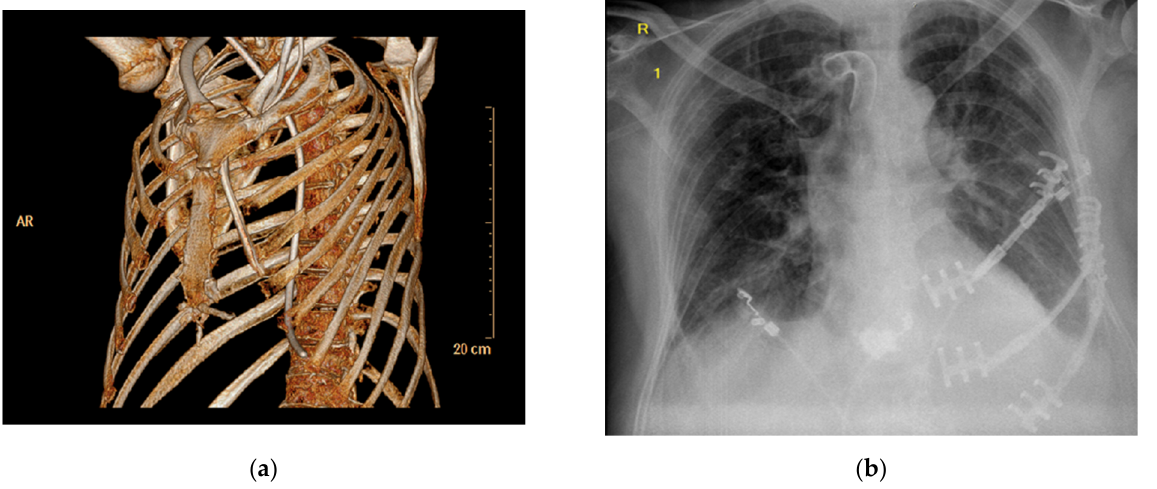
Figure 2. Chest CT reconstruction of a patient with multiple rib fractures and flail chest after 65 min of CPR, including the use of extracorporeal CPR, due to massive pulmonary embolism. ( a ) The patient underwent surgical rib fixation for stabilization ( b ) and was finally weaned from the ventilator after 37 days of mechanical ventilation.